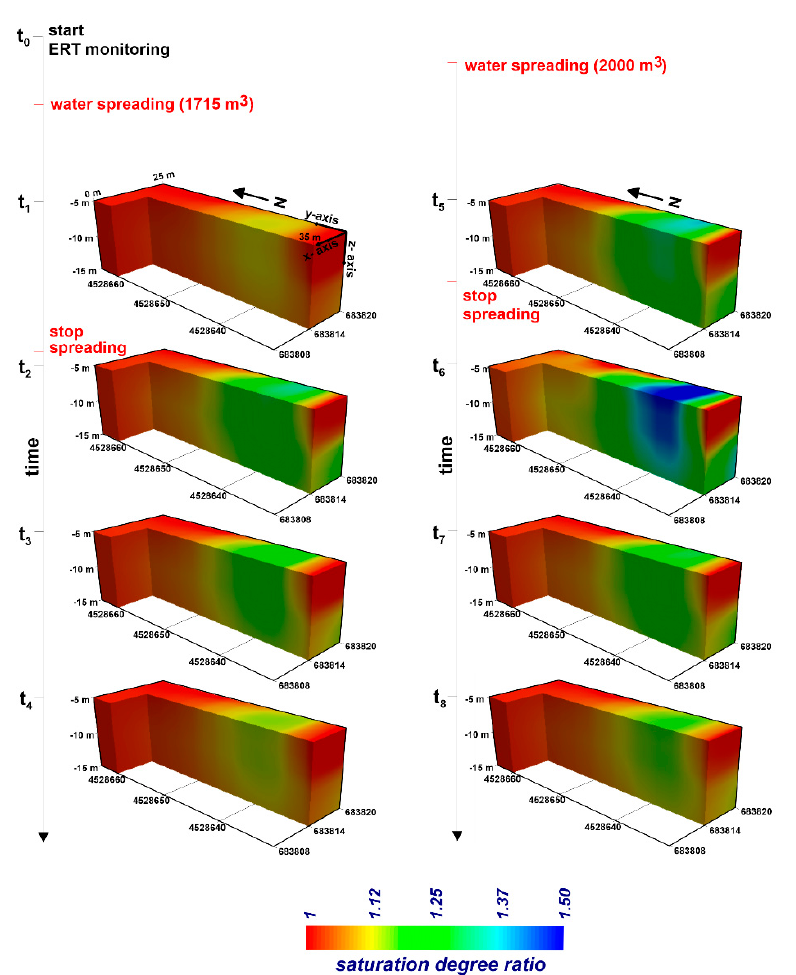
Figure 9. ERT-derived saturation degree recorded for Trench 9 in March after conversion using simplified Archie’s